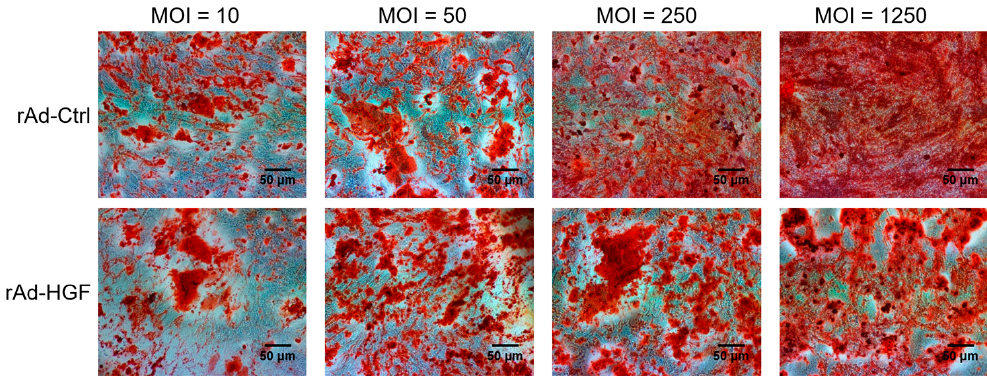
Figure 3. Effects of HGF overexpression on hBMSC osteogenesis. Human BMSCs were cultured in the osteogenic differentiation medium and infected with rAd-HGF or rAd-Ctrl at MOI = 10, 50, 250, and 1250. AR-S staining was used to assess the osteogenic level of hBMSCs. Results showed that osteogenesis occurred in cells infected with rAd-Ctrl or rAd-HGF, while overexpression of HGF further promoted such differentiation. The experiment has been replicated three times with similar results, and the representative results were